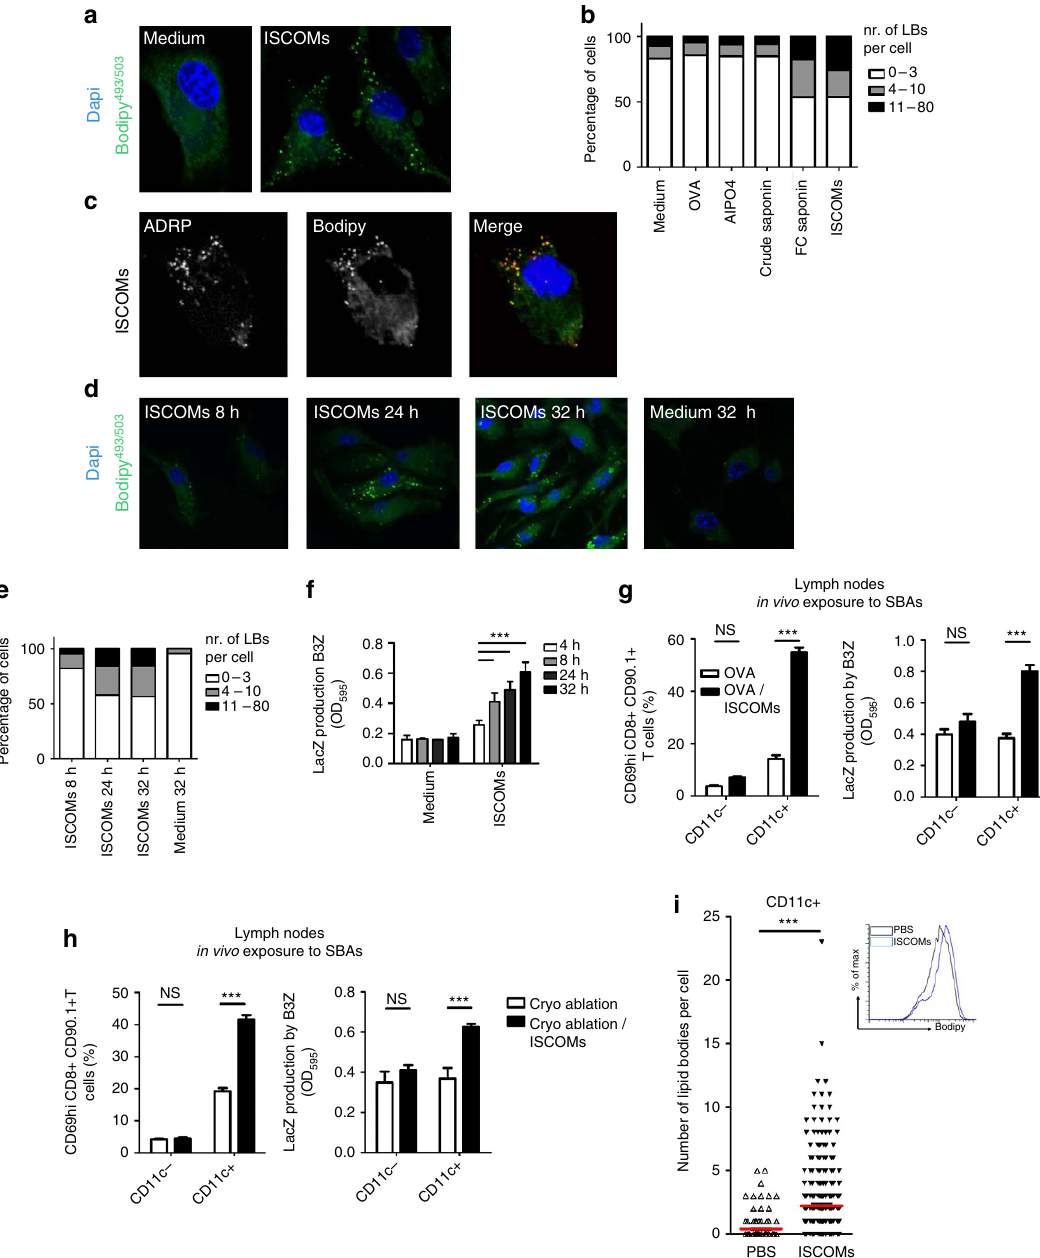
Figure 3 | SBAs induce in vitro and in vivo lipid bodies in correlation with cross-presentation. ( a – c ) GM-CSF-cultured BMDCs following 5h exposure to the indicated adjuvants were fixed and stained with the LB probe Bodipy 493/503 . Nuclei were counterstained with DAPI, and cells were analysed by